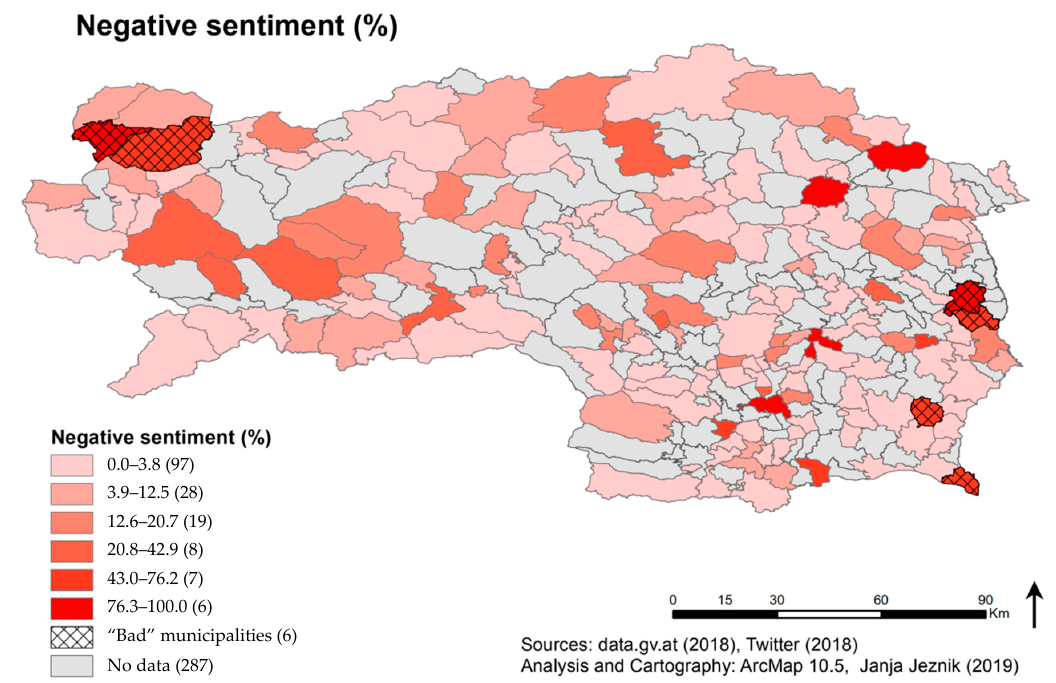
Figure 10. Results of the sentiment analysis. The percentage of the negative Tweets is depicted in this map in different classes. The tweets with negative sentiment are also a result of German place names that start with “Bad ... ”, denoting spa towns. The algorithm flags the German “Bad ... ” with the meaning of the English word “bad”. These six towns are marked with a cross hatch